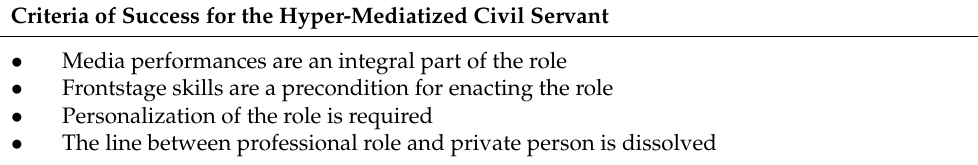
Table 3. New criteria of success arising with the hyper-mediatized role of the civil servant. Criteria of Success for the Hyper-Mediatized Civil